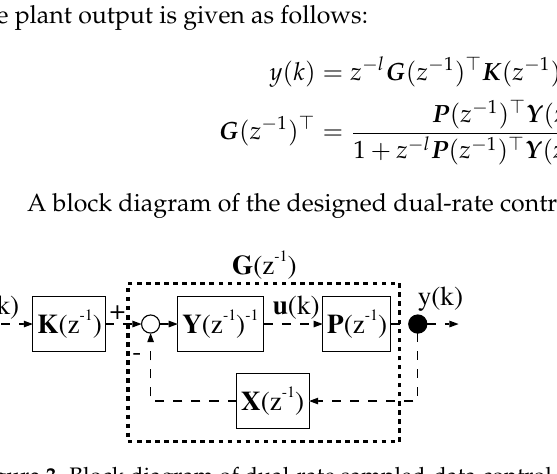
Figure 3. Block diagram of dual-rate sampled-data control